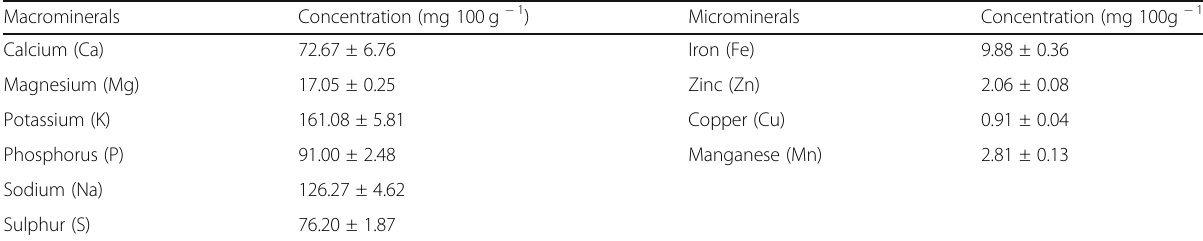
Table 1 Mineral content of crawfish minced